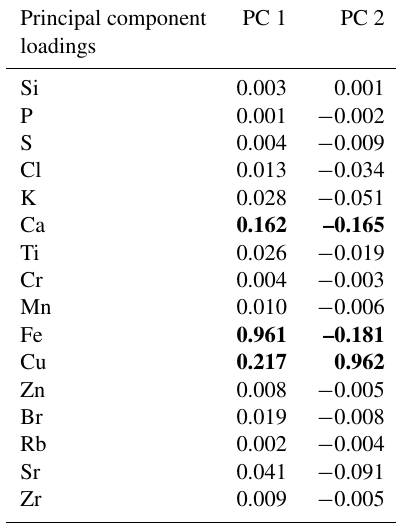
Table 2. Principal component analysis. The elements contributing to each principal component are shown; bold font highlights Fe, Cu, and Ca, which dominate the loadings. PC1 explains 93% of the variance (statistically significant), whereas PC2 explains only 6% of the variance and is not statistically significant. PC1 and PC2 through time are shown in Fig.